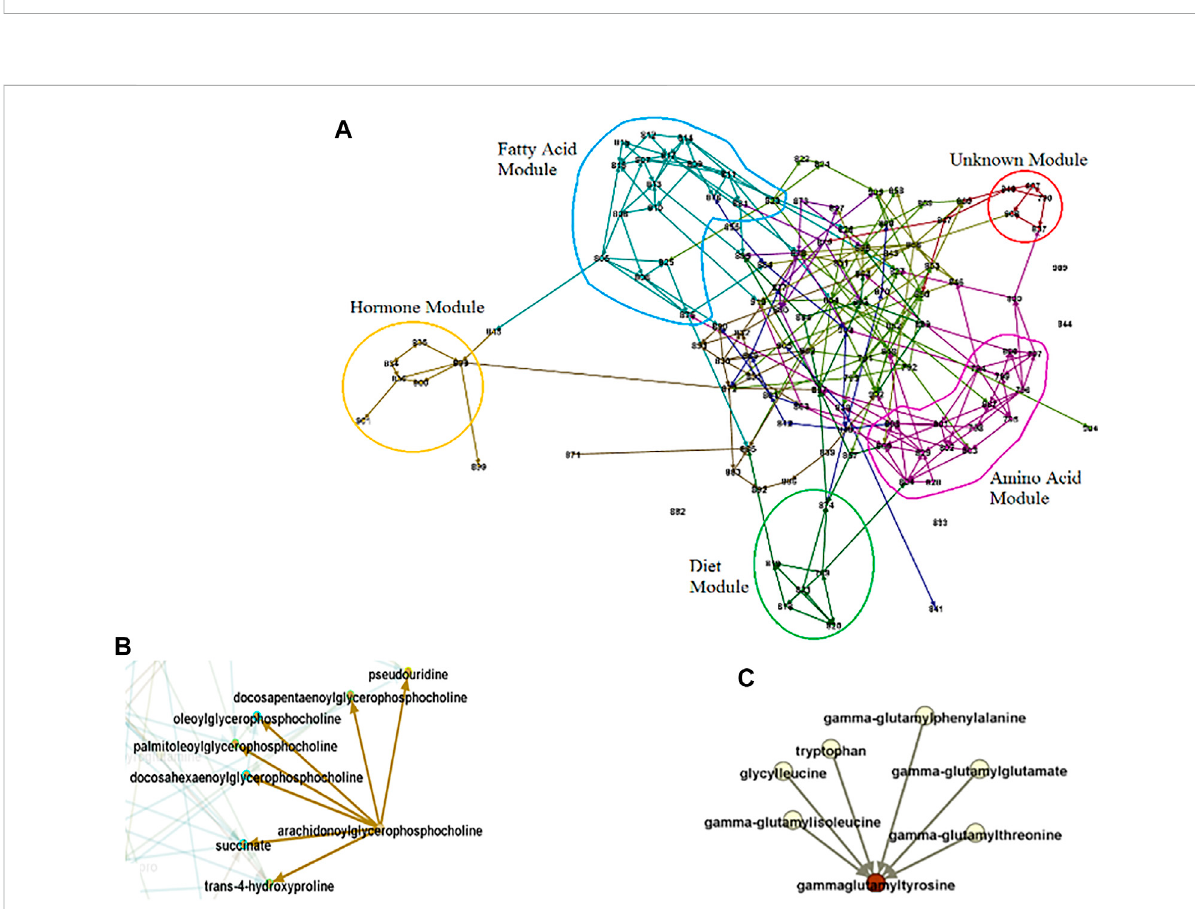
FIGURE 6 CausalNetworkParameters.Numbersstandformetabolites,edgesfor conditional dependenceproperties,andarrowsfor causalrelationships. (A). Modules. The set of entitiesthat highly interact. The identi fi ed modules generallycoincide with known pathways. For example, the blue and pink circles consist of related fatty acid and amino acid molecules respectively. (B). Example of a broadcaster. Intervention in broadcasters may change the level in the entire system since they directly or indirectly in fl uence multiple other entities in system. (C). Example of a receptor. The level of receptors may predict the level of the entire system since they capture the effect of multiple other